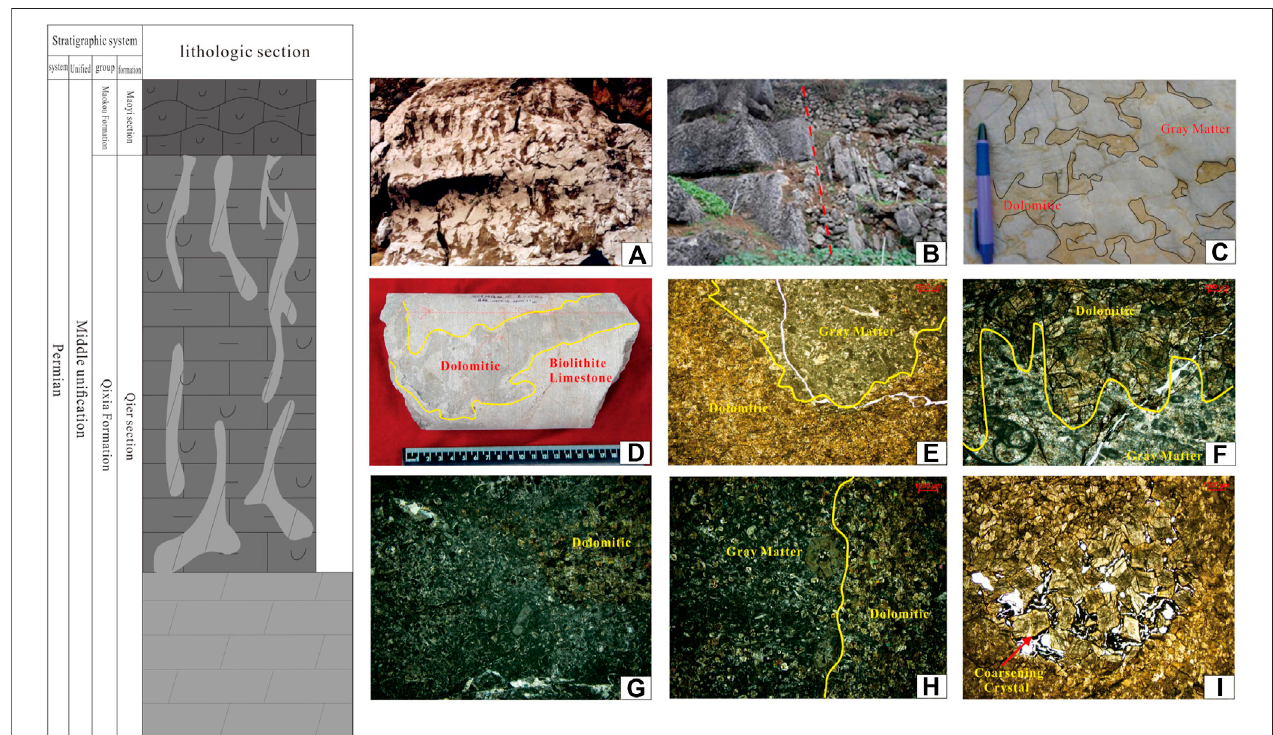
FIGURE 2 | Dolomite characteristics of Qixia Formation in the study area. (A) Depiction of the dolomitic “ leopard-spot ” limestones. Dolomization occurs due to cracking exposure, downward penetration of atmospheric fresh water along dry cracks, and mixture with seawater. As a result, base limestones have brecciated-vein structuresaftermetasomatism.TheyaredevelopedatthetopoftheQixiaFormation,Changyuanjiang,Guangyuancity,Sichuanprovince. (B) Thethick-layeredmassive dolomitic “ leopard-spot ” limestones at the top of the Qixia Formation are in abrupt contact with the middle-thin layered “ eyeball ” limestones in the overlying Maoyi Section. Dolomitic “ leopard-spots ” are distributed approximately vertical, Jinzi Mountain, Guangyuan city. (C) Dolomitic “ leopard-spot ” limestones. Networked dry cracks are developed on the surface, indicating sedimentation discontinuity caused by a short-term outcrop. Subsequently, different corrosions are formed on the outcrop surface due to atmospheric leaching, top Qixia Formation, Changjianggou, Guangyuan city. (D) Dolomitic “ leopard-spot ” limestones, K2 well, 2405.12 – 2405.32 m,QierSection. (E) Crystallinedolomite,developmentofneedle-likeporesandholes,ST12well,7077.50 – 7077.73 m,theupperpartofQierSection, ×10 ( − ). (F) Dolomitic “ leopard-spot ” limestones; dolomites are subhedral-automorphic fi ne-middle crystals, ST12 well, 7050.04 m, upper part of the Qier Section, ×10 (+). (G) Bioclasticlimestone,containingredalga,foraminiferandotherorganisms,weakdolomitization,ST12well,7051.49 m,theupperpartoftheQierSection,×10(+). (H) Depiction of dolomitic “ leopard-spot ” limestones, where dolomites are subhedral-automorphic fi ne-middle crystals. Limestones contain biological fossils such as crinoids, ST12 well, 7051.7 m, the upper part of the Qier Section, ×10 (+). (I) Crystalline dolomite, the intergranular pores are developed and the corrosion is enlarged. Thecontactrelationofcrystalsisirregular.Crystalcoarseningcanbeseen.Theintergranularporesaredeveloped,whicharesemi- fi lledbyasphalt.ST12well,7059.9 m, Qier Section, ×10 (-).